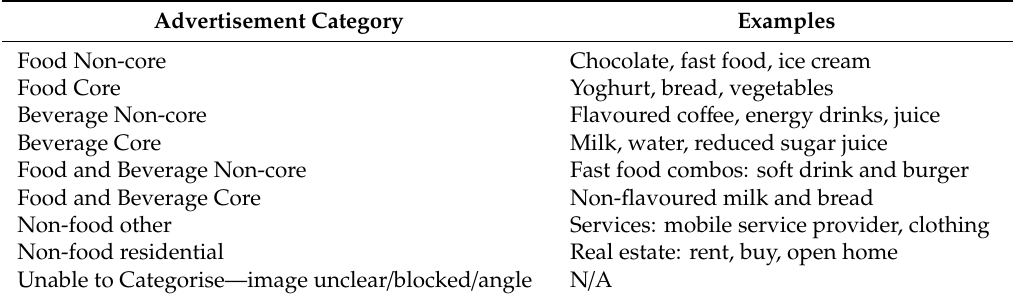
Table 1. Advertisements Identified by Category.